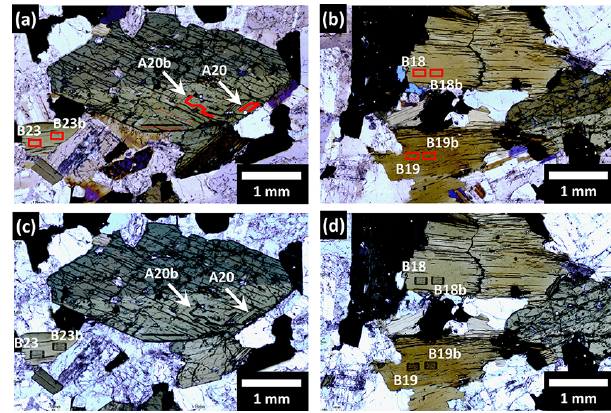
Figure 2. Photomicrographs before and after fsLA-MC-ICP-MS. Red rectangles and lines indicate laser ablation locations. Amphi- bole before (a) and after (c) fsLA-MC-ICP-MS. Biotite before (b) and after (d) fsLA-MC-ICP-MS.